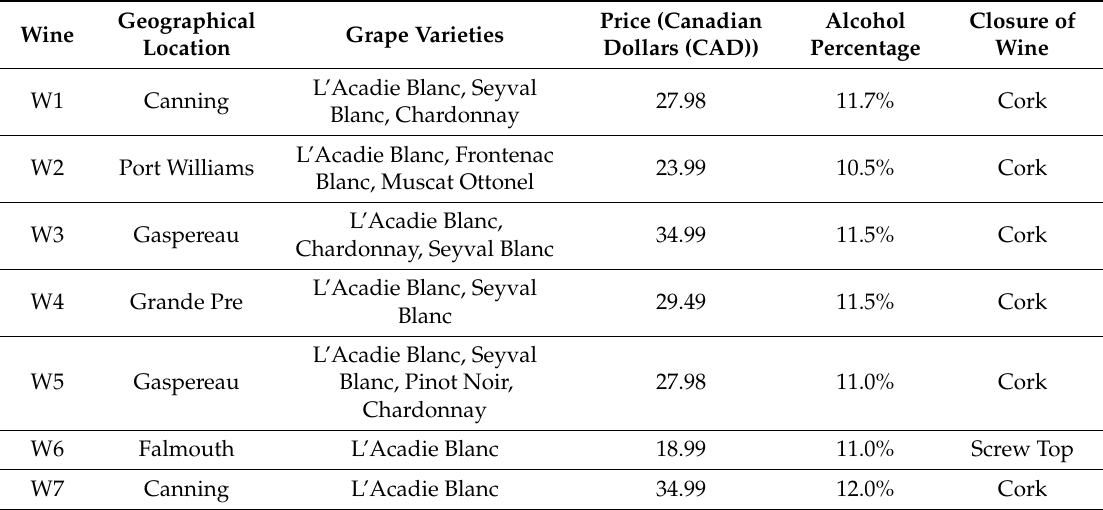
Table 1. Geographical location, grape variety, price, alcohol percentage, and closure of wines assessed in the projective mapping